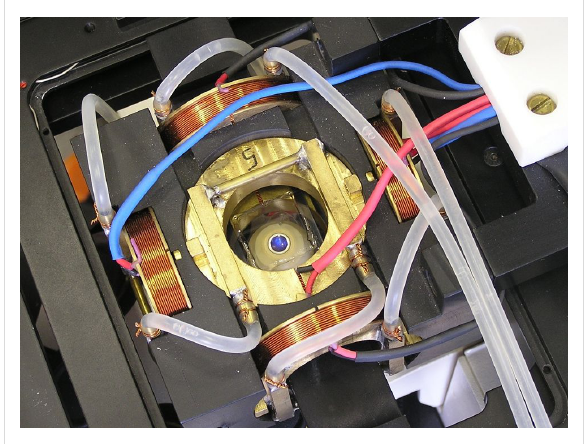
Figure 5: Magneto-optical tweezers used in the experiment. Three pairs of water-cooled coils ensured an almost homogeneous magnetic field at the